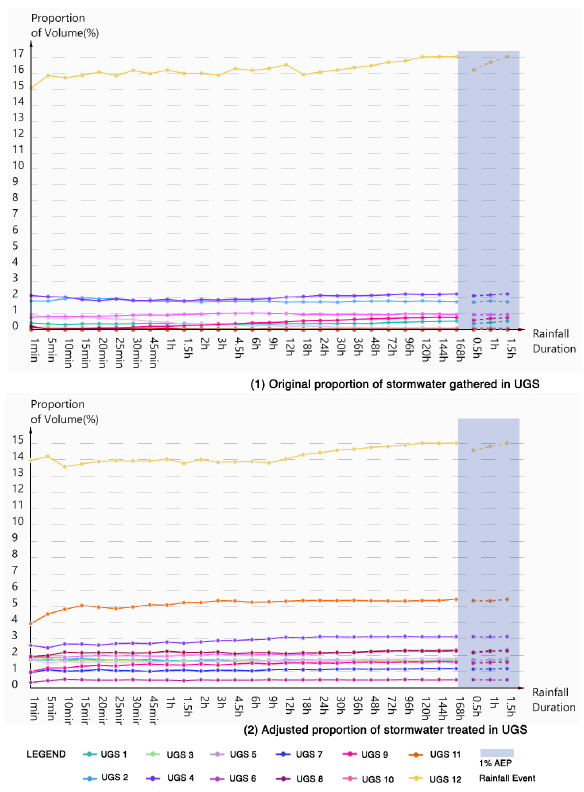
Figure 10. Particle size Testing Result For Test Site